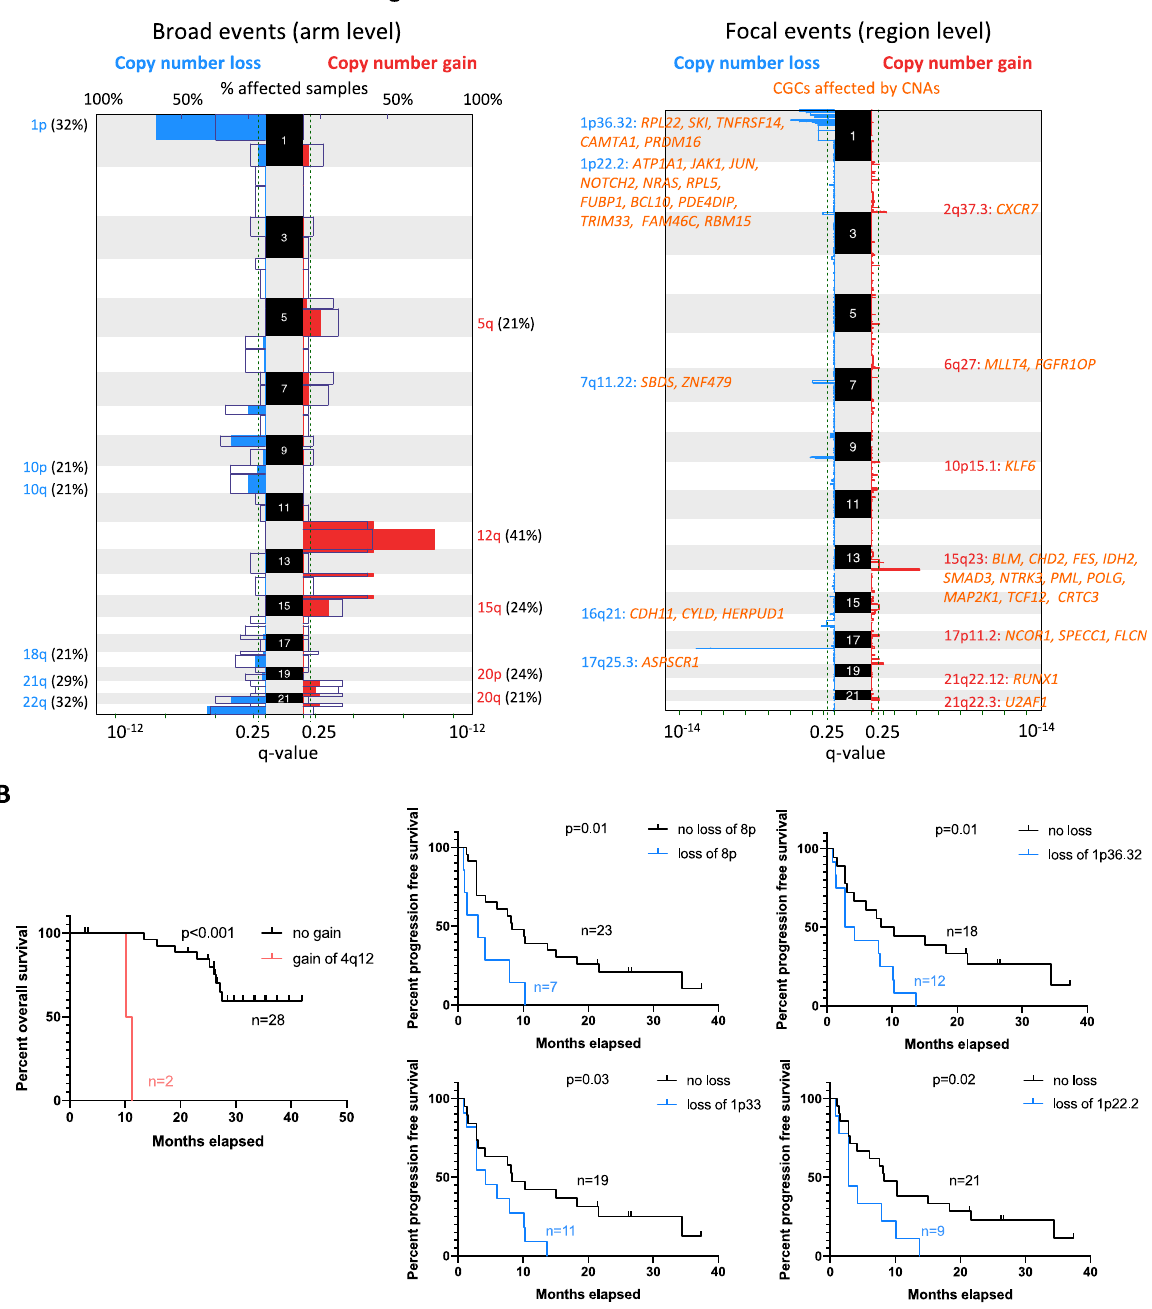
Figure 2. Global CNA profiles and their correlation with survival. ( A ) Recurrent alterations were identified at chromosomal arm (broad) and region levels (focal) in 24 cases. Colored peaks represent gains/losses by broad (chromosome arm) or focal (region) events; the threshold of significance is q-value < 0.25; numbers in bracket represent % of samples affected by copy number alterations. CGCs that were affected by focal CNAs are listed and coded in orange. ( B ) Kaplan–Meier estimate of overall and progression-free survival in ASPS patients with different statuses of can; p -value is shown for cases with the copy number change vs . no change.